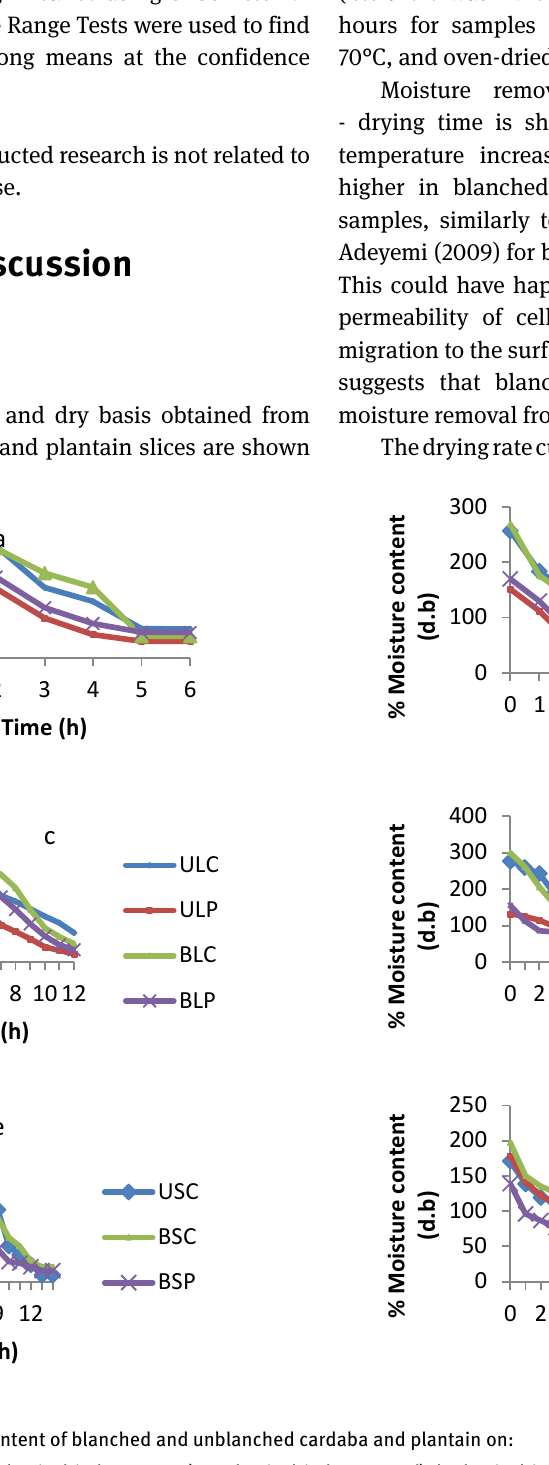
Figure 1: Percentage moisture content of blanched and unblanched cardaba and plantain on: a) wet basis dried at 70 ºC b) dry basis dried at 70 ºC c) wet basis dried at 50 ºC d) dry basis dried at 50 ºC e)